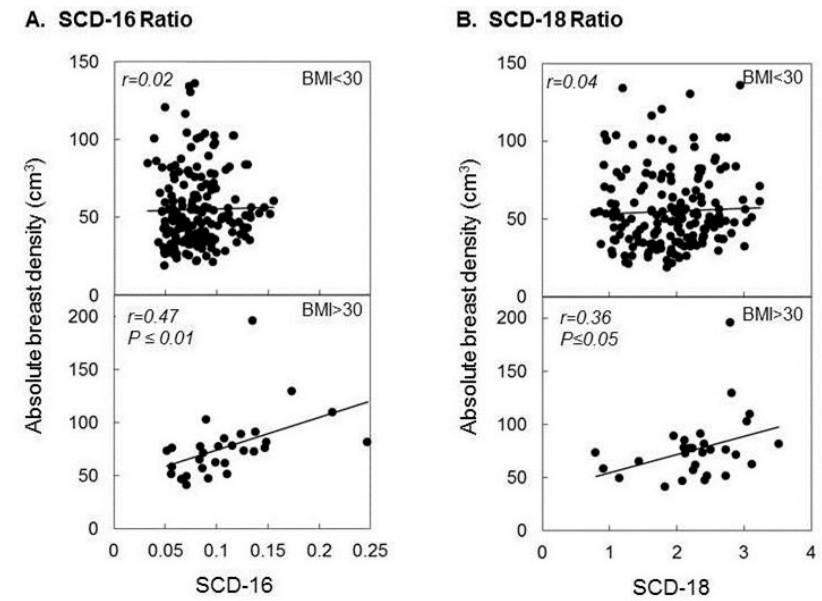
Figure 3. Correlation between SCD-1 activity, expressed as either SCD-16 ratio ( A ) or SCD-18 ratio ( B ) and absolute breast density in women with BMI < 30 (upper panels) or >30 (lower panels). Reproduced with permission from [63].